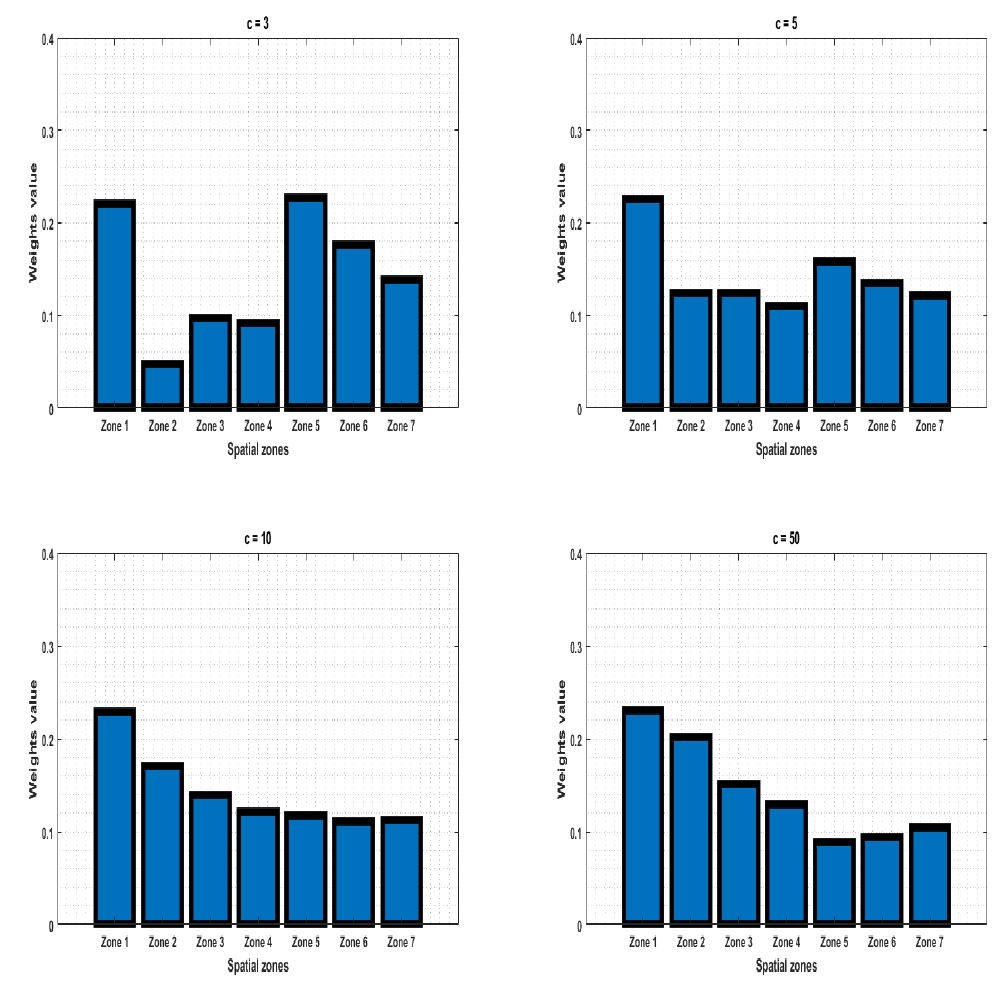
Figure 14. Spatial resource allocation of the seven zones for different values of c according to Lemma